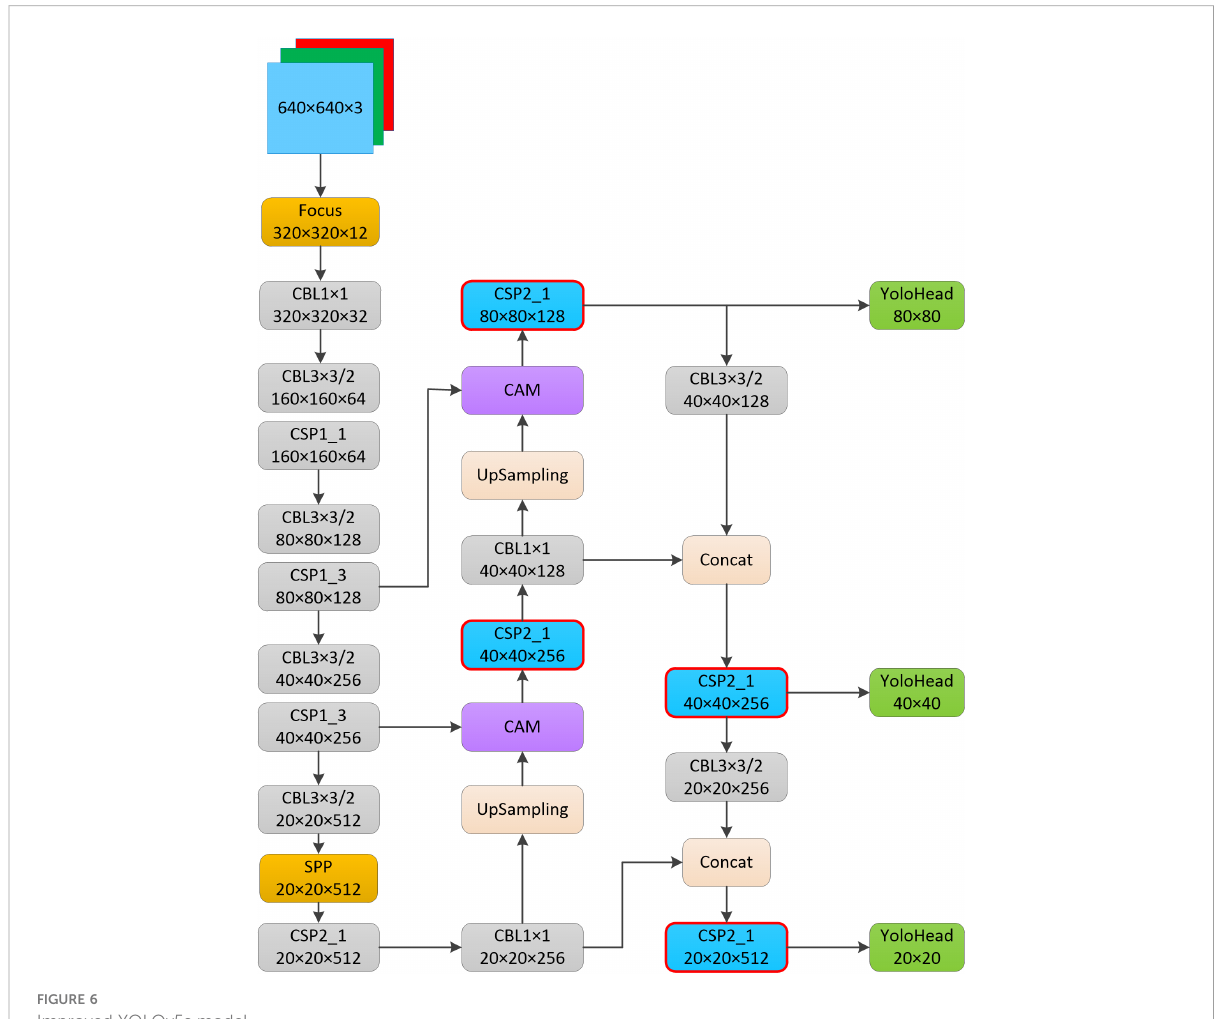
FIGURE 6 Improved YOLOv5s